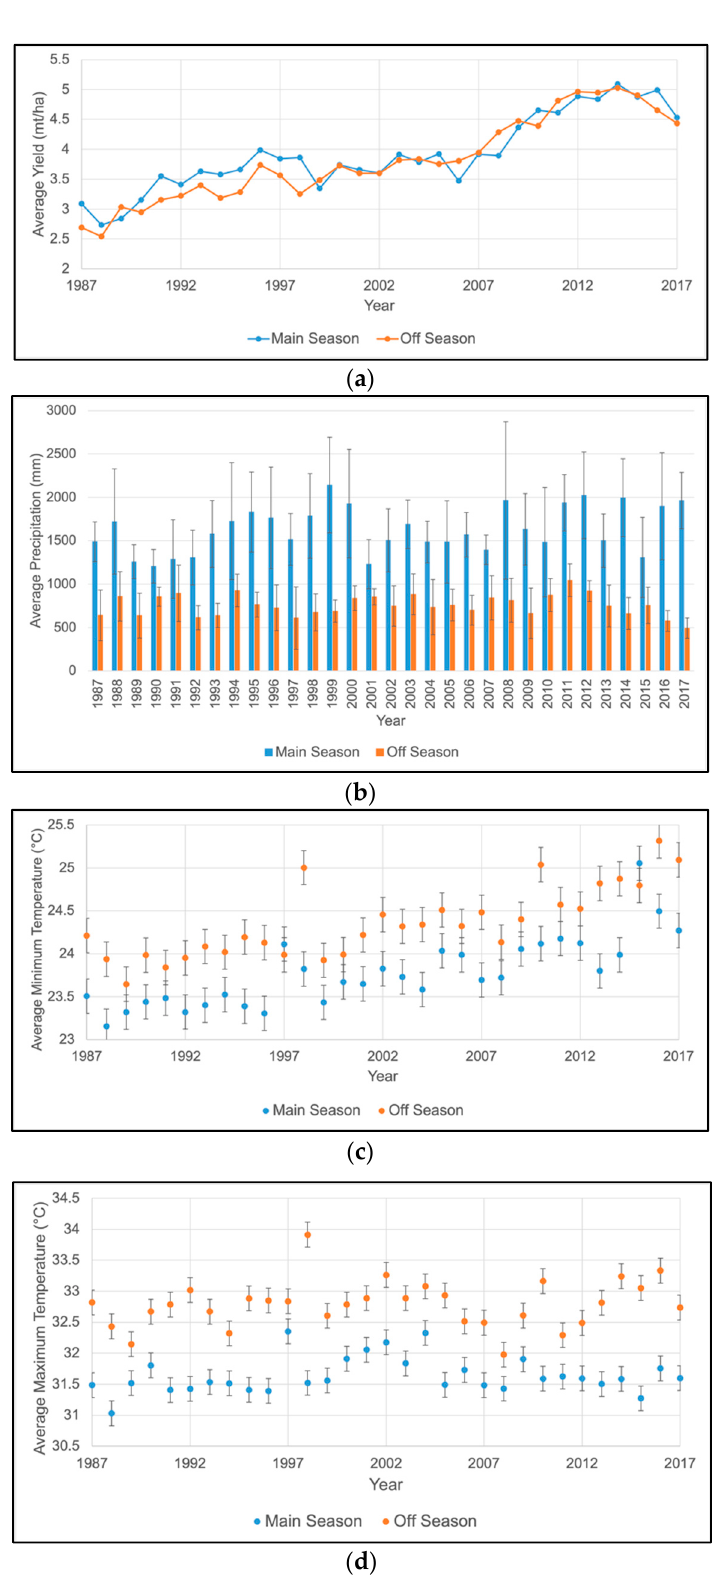
Figure 3. Comparison of historical changes over the 1987–2017 period by cropping season. ( a ) Average yield of eight granaries (mt/ha). ( b ) Average sum of precipitation (mm) with error bars showing one standard deviation. ( c ) Average minimum temperature (°C) with error bars are +/ − 0.2 °C. ( d ) Average maximum temperature (°C) with error bars are +/ − 0.2 °C.